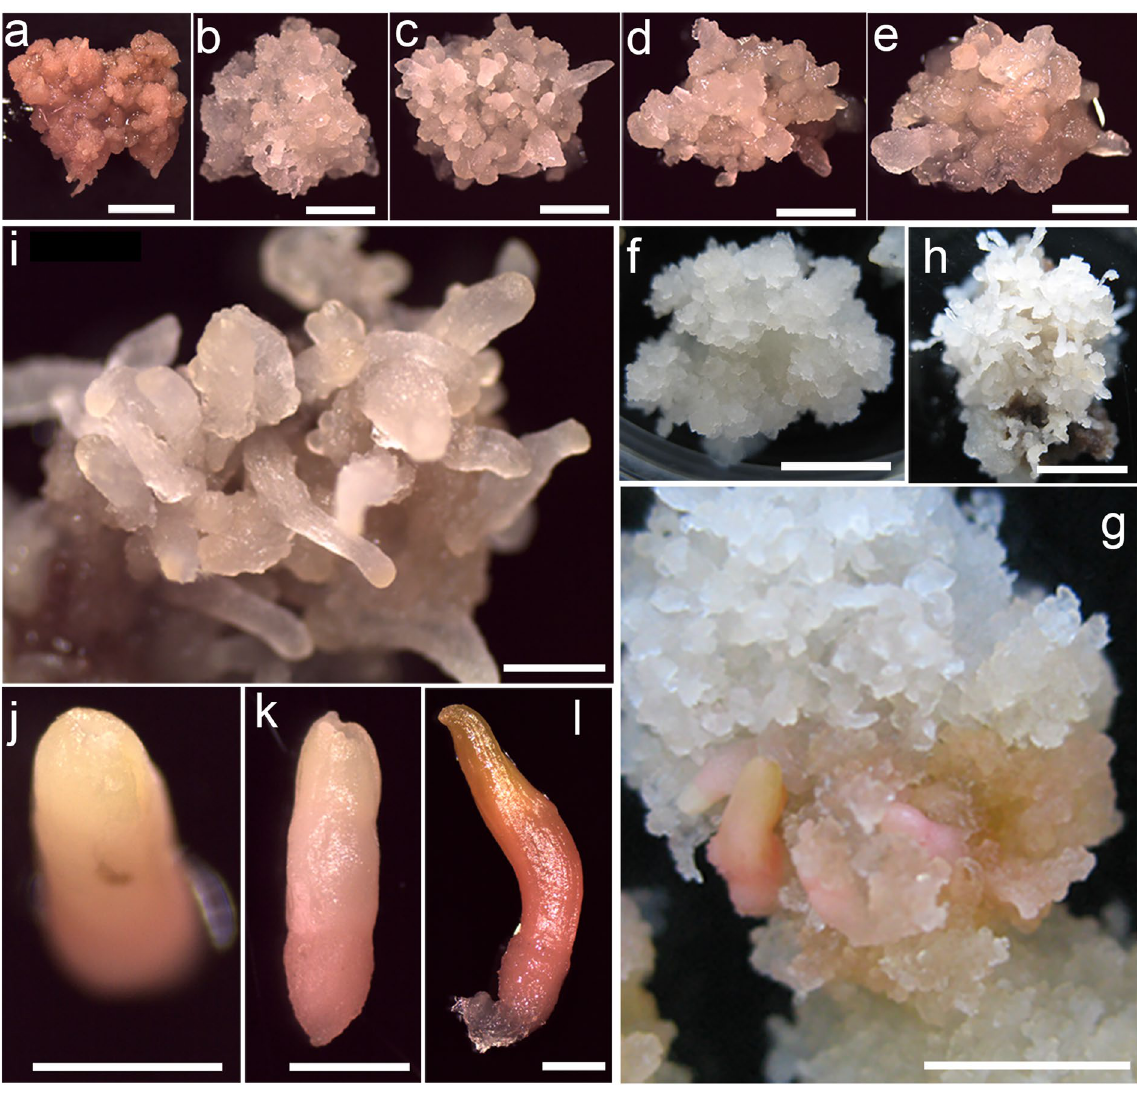
Figure 9. Effects of ABA and PEG on the potential for somatic embryogenesis. ( a–e ) Early somatic embryo developmental potential after 2 weeks’ cultivation of embryogenic calluses in maturation media supplemented with five concentrations of ABA (0, 25, 50, 75, and 100 μ mol L − 1 ) respectively. ( f–h ) Early somatic embryo developmental potential in maturation media supplemented with three concentrations of PEG6000 (50, 100, and 150 g L − 1 ), respectively. ( i ) Early somatic embryo developmental potential in maturation media supplemented with 50 μ mol L − 1 ABA and 100 and 150 g L − 1 PEG6000. ( j–l ) As maturation progressed, early somatic embryos ( j ) gradually differentiated into early cotyledonary embryos ( k ) and finally developed into mature embryos (l). ( a–h ) bars 5 mm, ( i–l ) bars 1